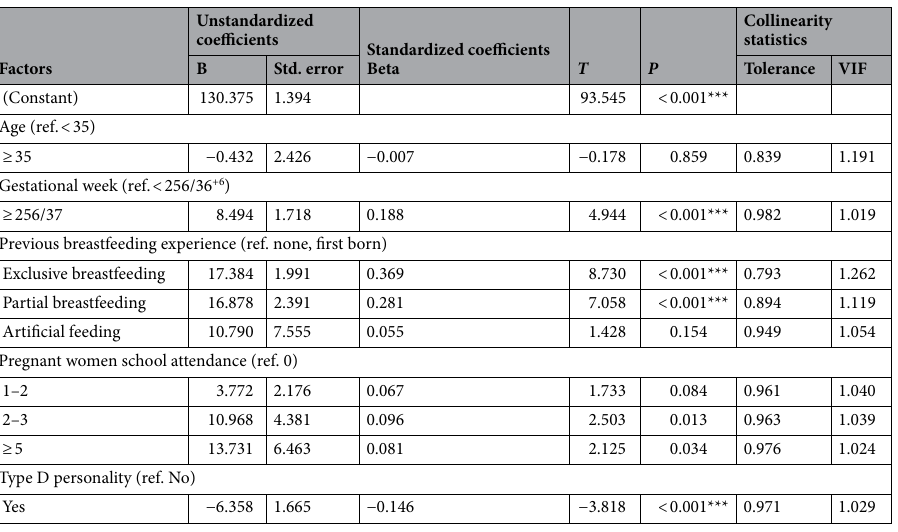
Table 3. Multivariate analysis of breastfeeding competency level (n = 525). * P < 0.05; ** P < 0.01; *** P <